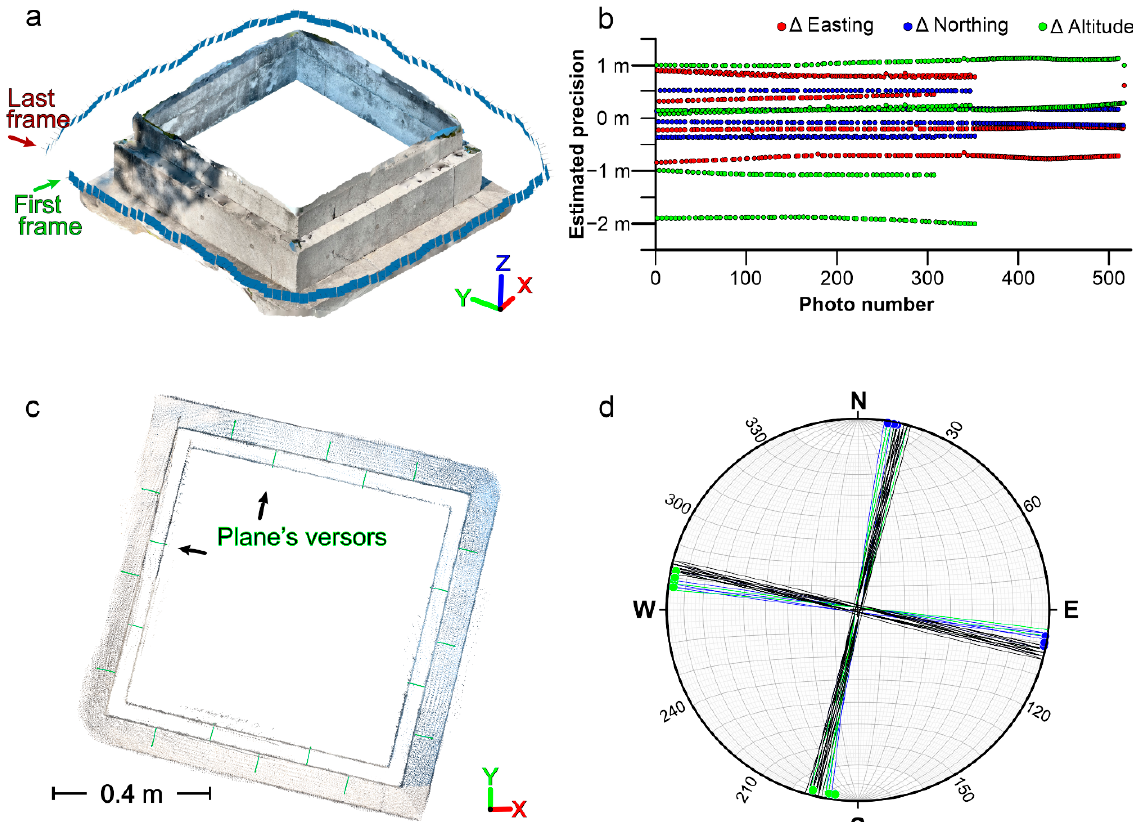
Figure 7. ( a ) SfM ‐ MVS photogrammetric reconstruction of the base of the obelisk by means of oriented images captured by the PIX4Dcatch app. ( b ) Precision estimates of the image geotags collected by the PIX4Dcatch app. Each independent acquisition is identifiable by the different number of photos. ( c ) Orientation data of the orthogonal walls of the obelisk measured in CloudCompare from the LiDAR derived models. ( d ) Lower hemisphere, equal ‐ area projection of measurements taken in CloudCompare (black great circles) and in the field using the Clino (green) and FieldMove (blue) apps. Green and blue great circles are the walls of the obelisks, whilst the markers are their trend axes.